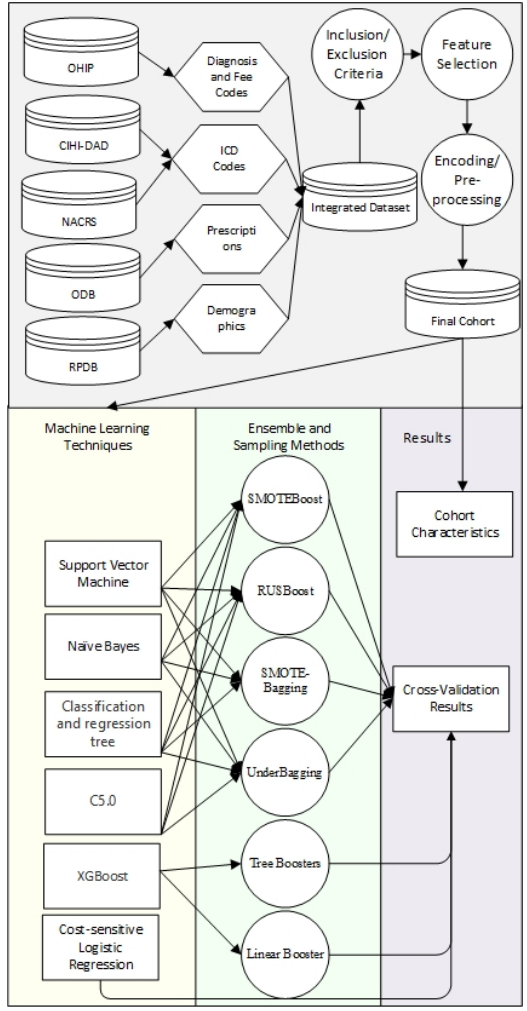
Figure 1. Workflow diagram of the presented study where different colors are used to represent three main parts (data integration and preprocessing, analysis and validation). The figure shows how different combinations are formed using two sampling techniques (i.e., under sampling and synthetic minority over-sampling technique), three ensemble methods (i.e., boosting, bagging and XGBoost), and eight machine learning classifiers.